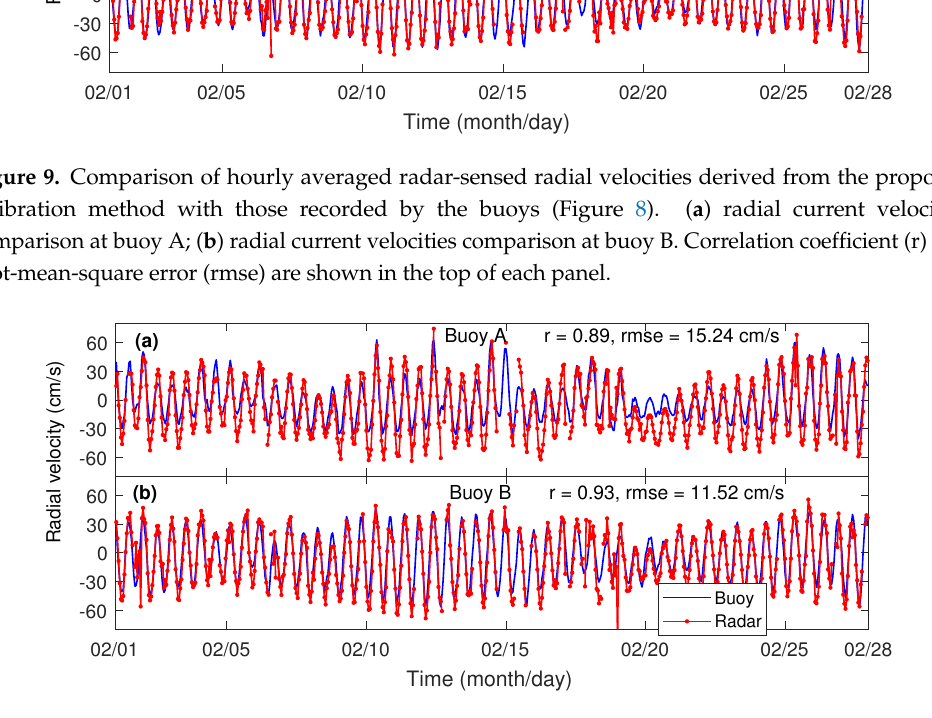
Figure 10. As in Figure 9, but for radar-sensed current velocities extracted with the conventional calibration method. ( a ) radial current velocities comparison at buoy A; ( b ) radial current velocities comparison at buoy